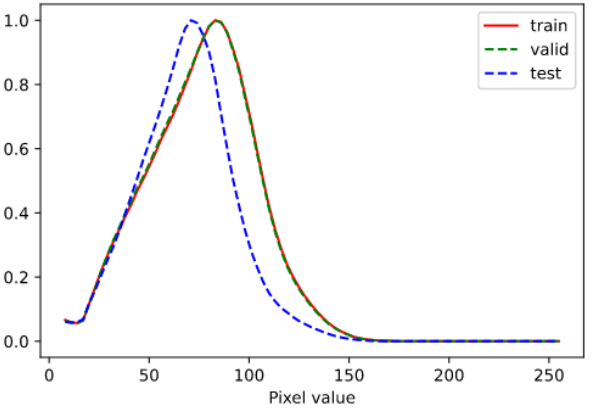
Figure 9. The histograms of non-zeros pixel values in the train-sets, validation-set and test-set